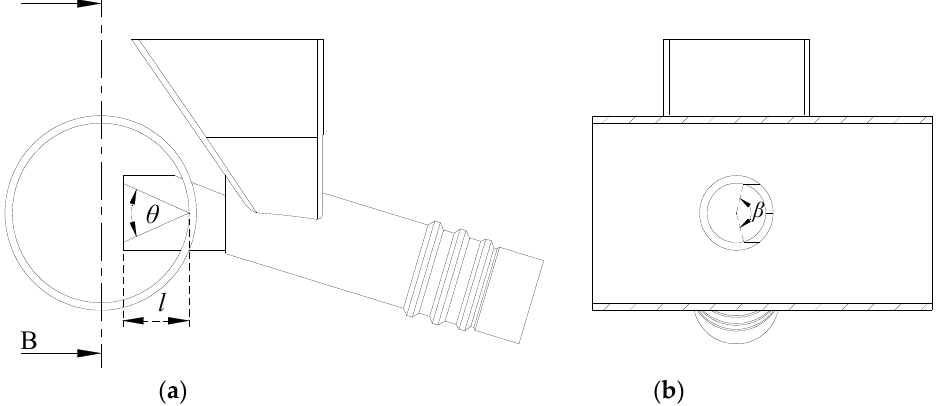
Figure 3. Structures of an airflow equaliser in the duct: β is on the cross-section of a branch pipe, θ is on the cross-section of the duct. ( a ) Side view of the pneumatic conveying line and ( b ) B–B section view.